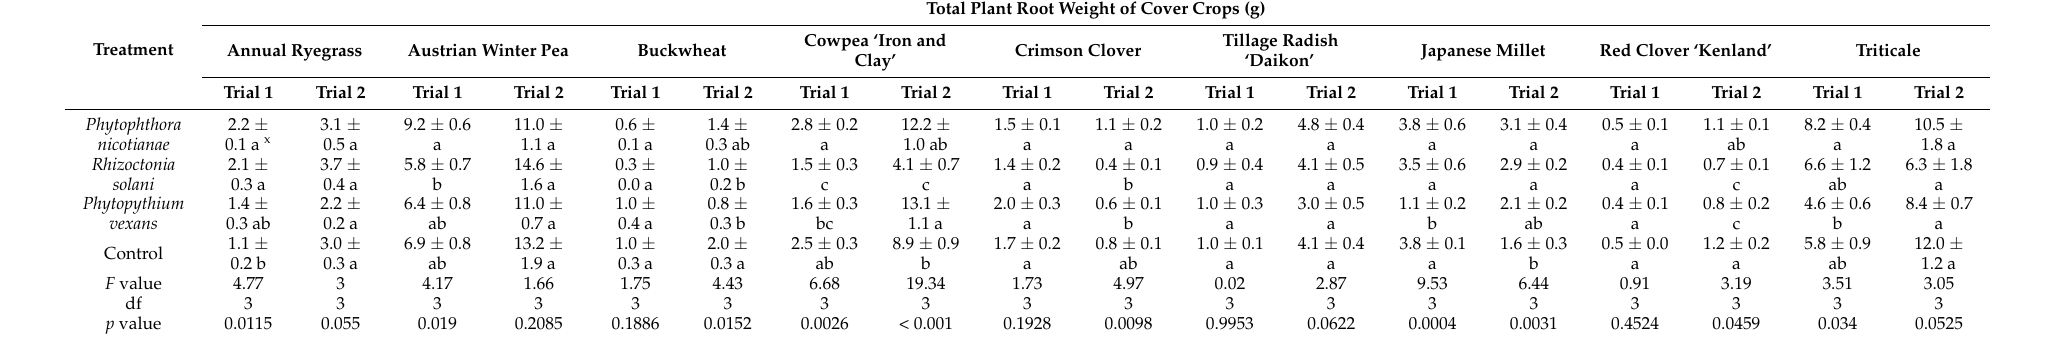
Table 4. Total plant root weight of different cover crops with the respective treatments of Phytophthora nicotianae , Phytopythium vexans , Rhizoctonia solani, and control.